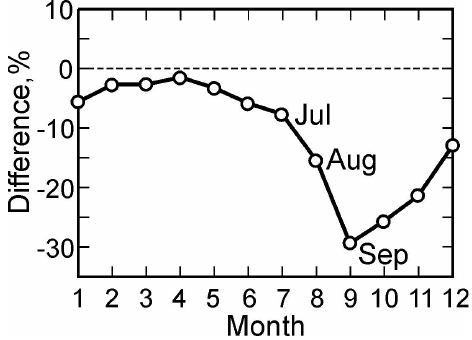
Fig. 5. Relative percent difference between monthly mean total ozone in the periods 1999–2008 and 1979–1983 averaged over the Southern polar region (70 ◦ –90 ◦ S). The zonal mean MSR data are